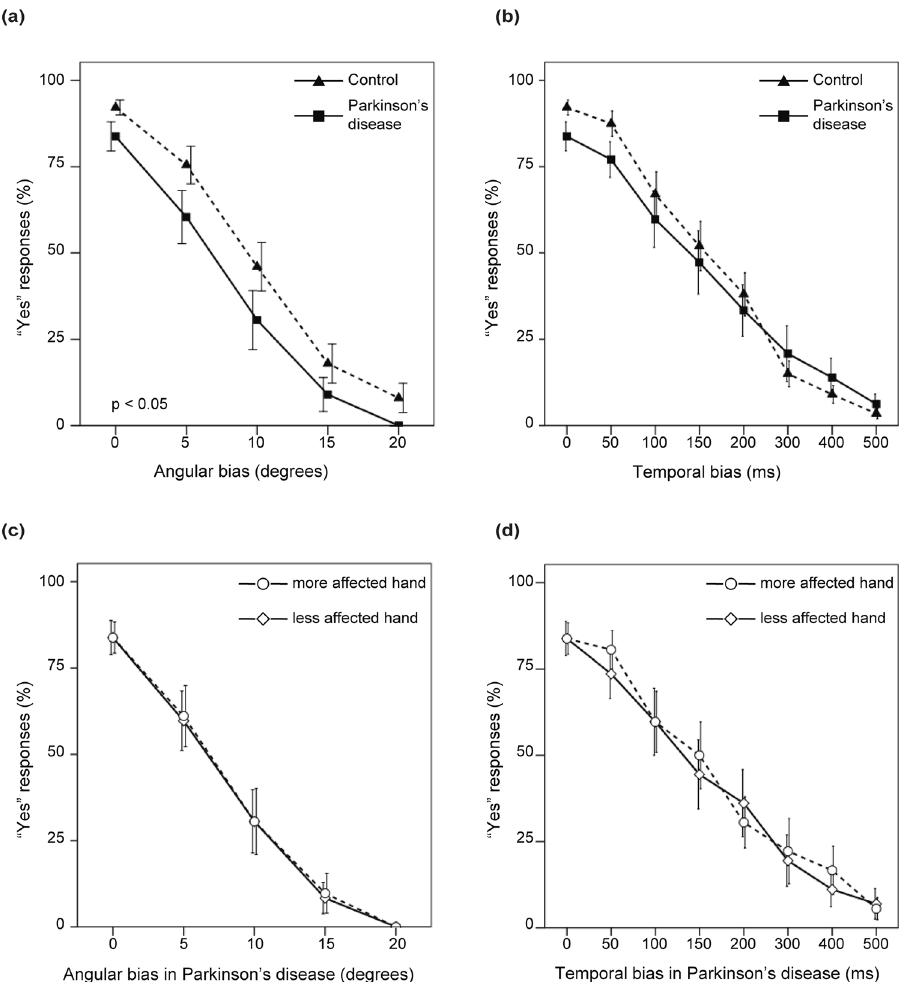
Figure 2. “Yes” responses for judgements in relation to the movements on screen with their actual movements. Bars represent standard